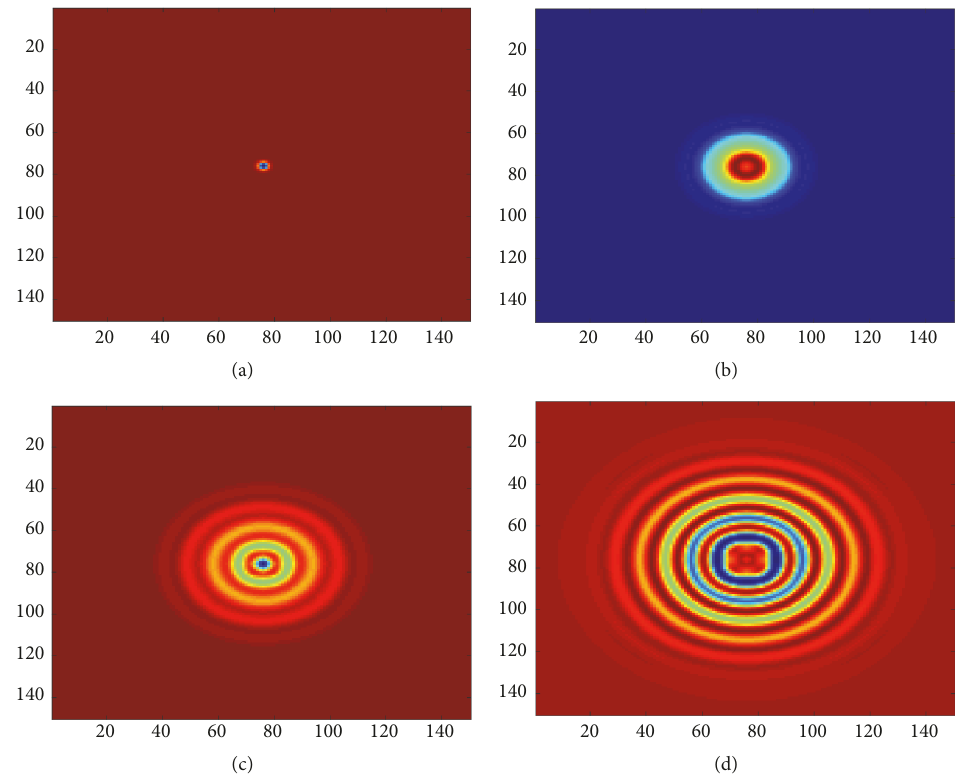
Figure 9: The snapshots of spatial distribution of membrane potential with color scale for neurons in the square array network for 𝑘 = 0.9 and 𝐷 = 1 at (a) 𝑡 = 2 time units, (b) 𝑡 = 75 time units, (c) 𝑡 = 170 time units, and (d) 𝑡 = 300 time units.